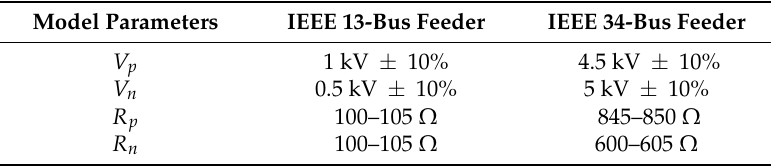
Table 1. High impedance fault (HIF) model parameters.